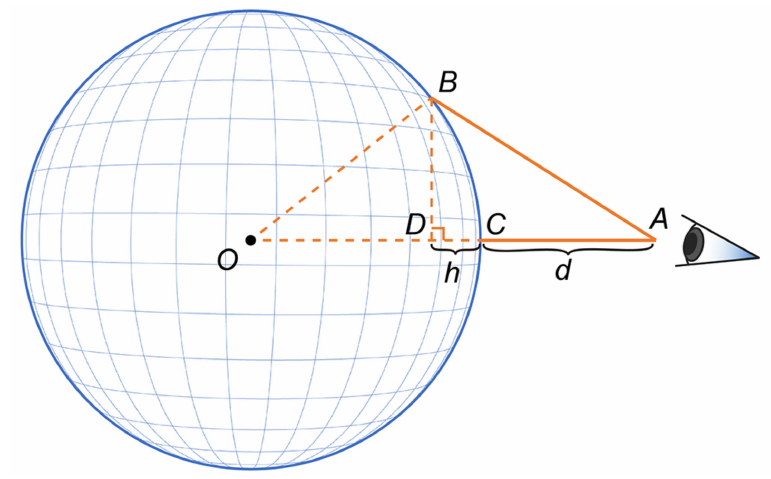
Figure 4. The relation between viewing distance and h in Figure